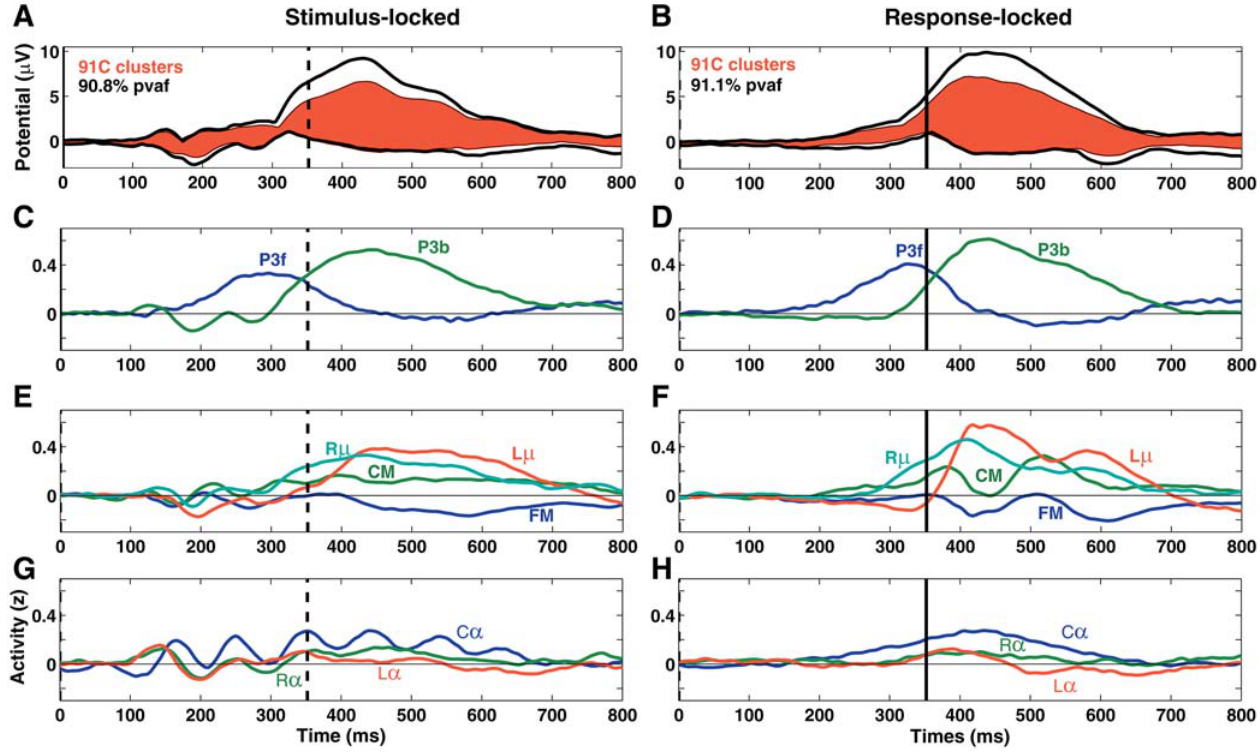
Figure 10. Component Time Courses and Summed Scalp Projections Summed projections (A and B) to the grand mean ERP average of all trials time-locked to stimulus onsets (left) and to subject responses (right), plus (C–H) grand mean normalized activity time courses of each of the nine independent component clusters, scaled and separated into the same cluster groupings as in Figures 6–9. For comparison with the stimulus-locked responses (left), response-locked data epochs (right) are shown aligned to the mean subject-median response time (352 ms, dashed line in left panels). DOI: